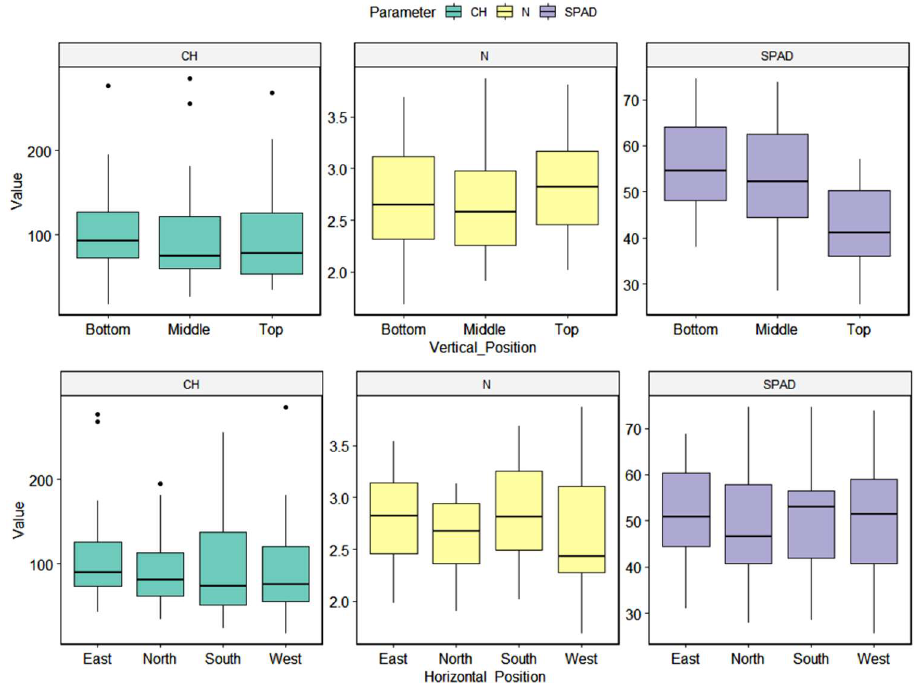
Figure 8. Spatial differences in the physiological parameters of tea. Dots represent outliers, the upper and lower ends of the vertical line represent the maximum and minimum values, respectively, the top and bottom lines of the box represent the upper and lower quartiles, respectively, and the horizontal line in the box represents the median. SPAD, the value measured with the spad-502 plus instrument; CH, total chlorophyll content; and N, total nitrogen content.